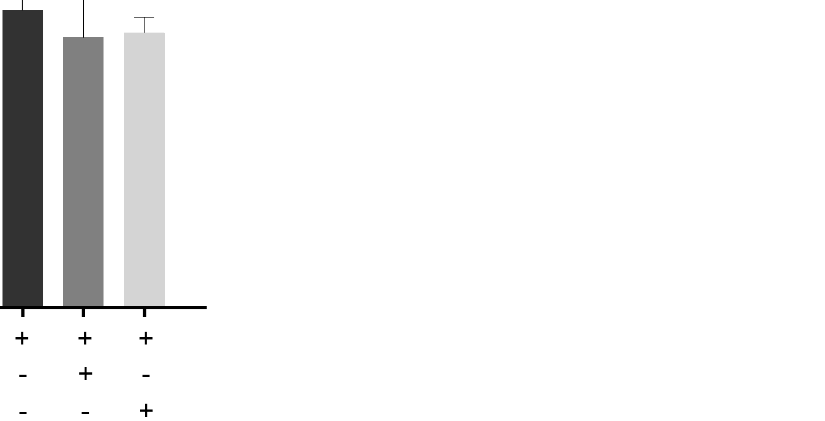
Figure 4. Co-exposure of MDA-MB-231 cells to CM3D or CM2D maintained the anti-invasion effect of Dox. The effect of CM2D or CM3D in combination with Dox (100 nM) on the chemoinvasion ability of MDA-MB-231 cells was evaluated by transwell assay. Results are expressed in percentage to control (mean ± SD, n = 4–6). Grid line represents 100% cell viability (control). CM2D, condi- tioned medium derived from 2D cultures; CM3D, conditioned medium derived from 3D cultures; Dox,